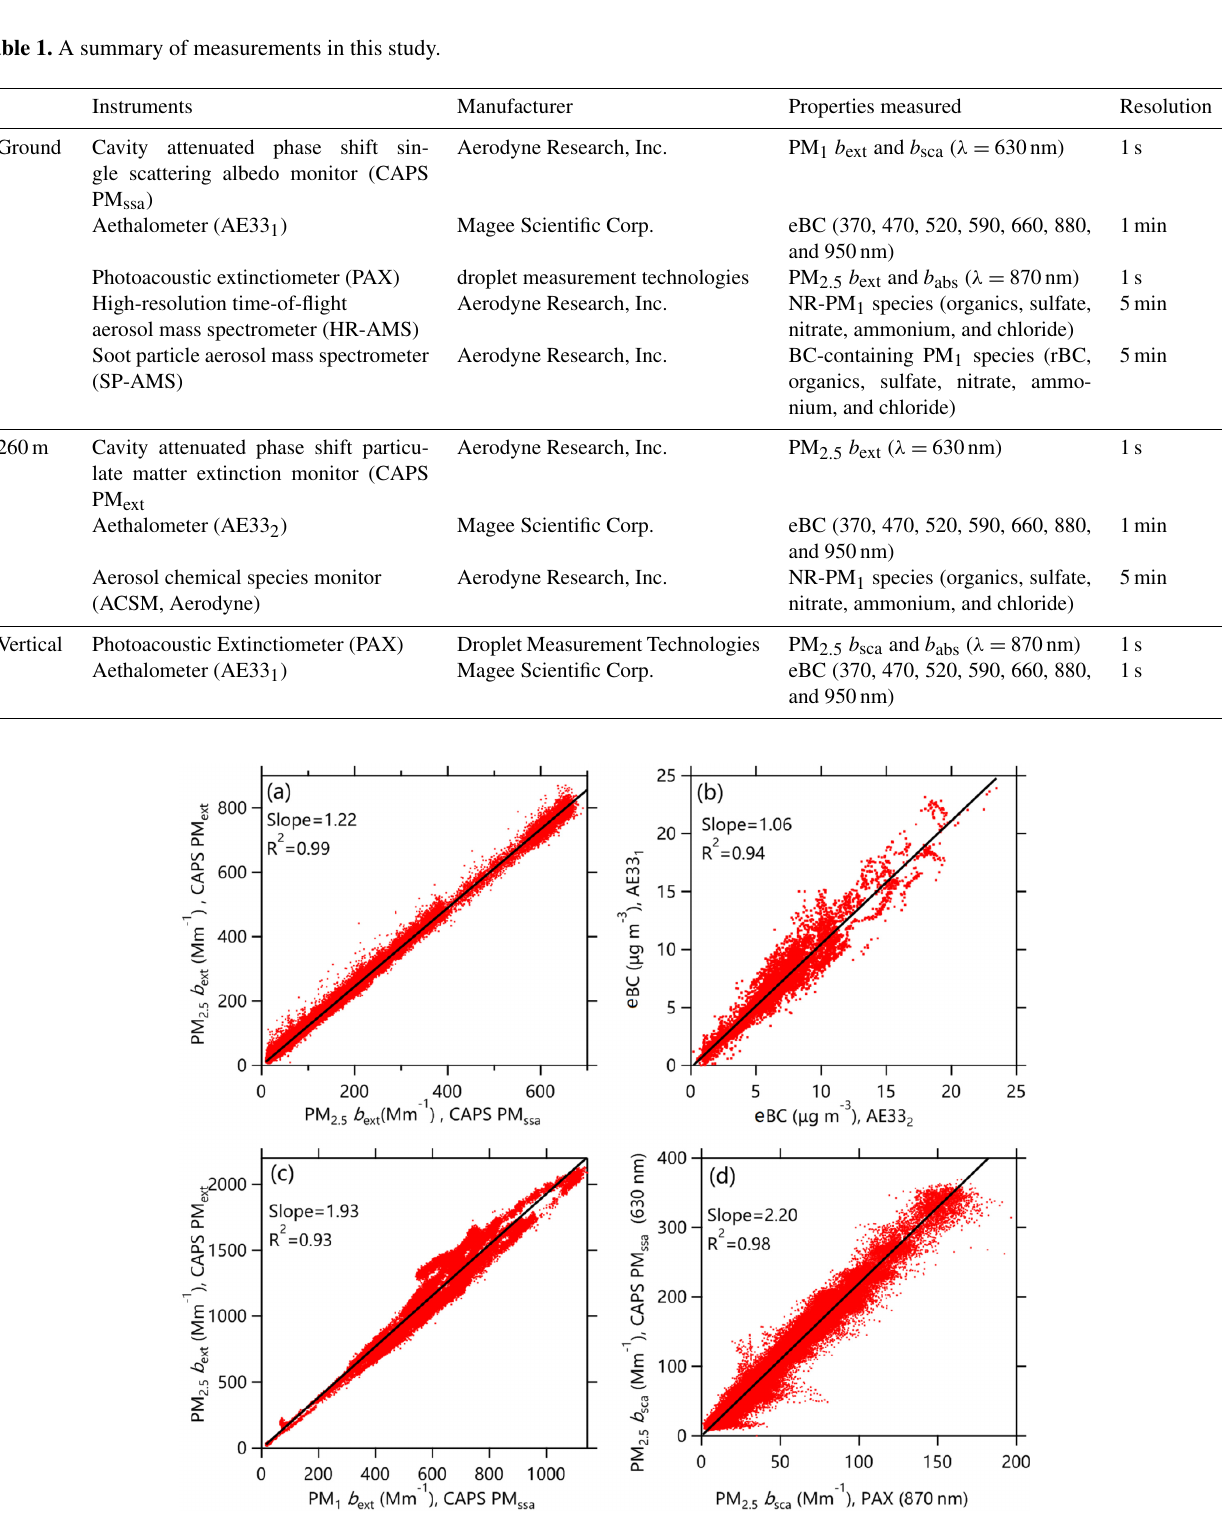
Figure 1. Intercomparisons of aerosol optical properties and BC: (a) b ext of PM 2 . 5 from CAPS PM ext and CAPS PM ssa , (b) eBC from two AE33s, (c) b ext of PM 2 . 5 from CAPS PM ext vs. b ext of PM 1 from CAPS PM ssa , (d) b sca from CAPS PM ssa vs. b sca from PAX.